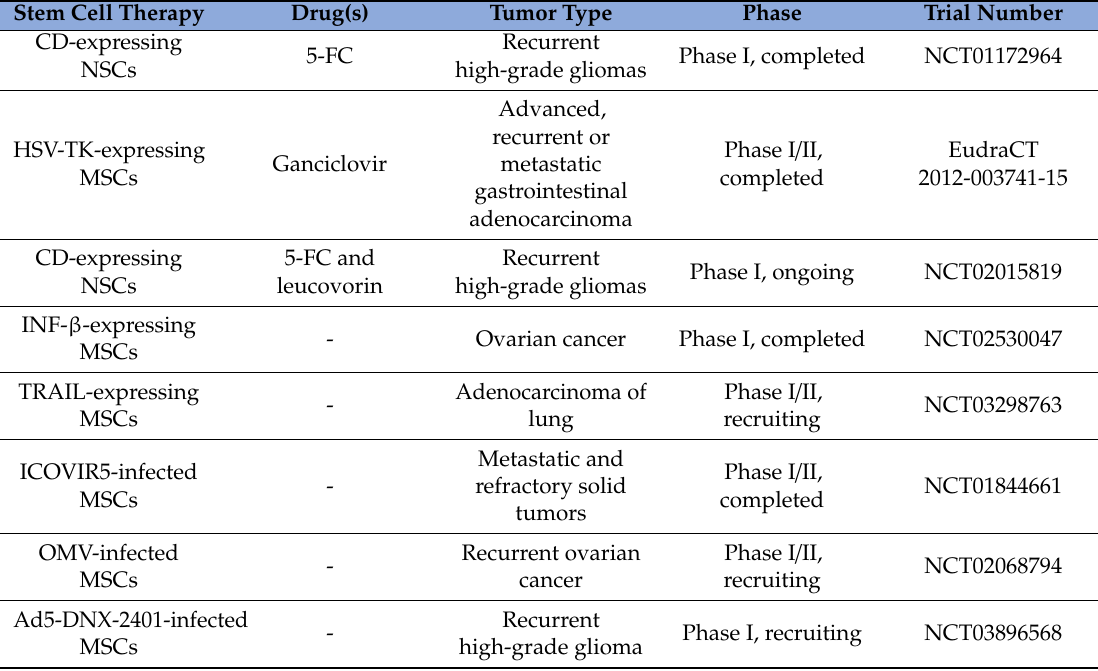
Table 2. Selected clinical trials of using stem cells as therapeutic carriers to treat cancers. Stem Cell